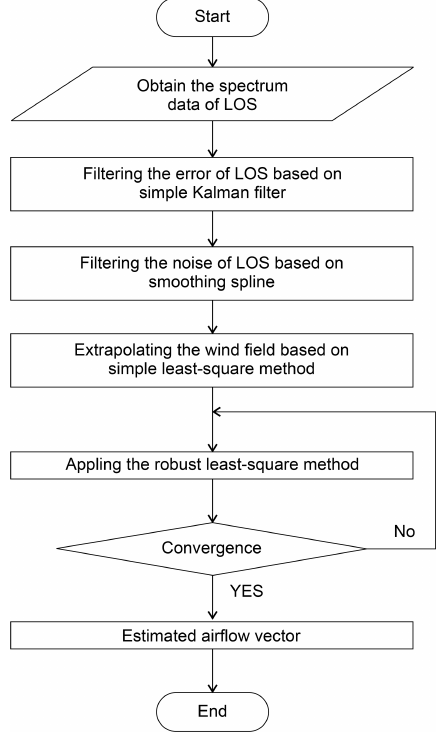
Figure 7. System flowchart for the airflow-vector-estimation algo- rithm.